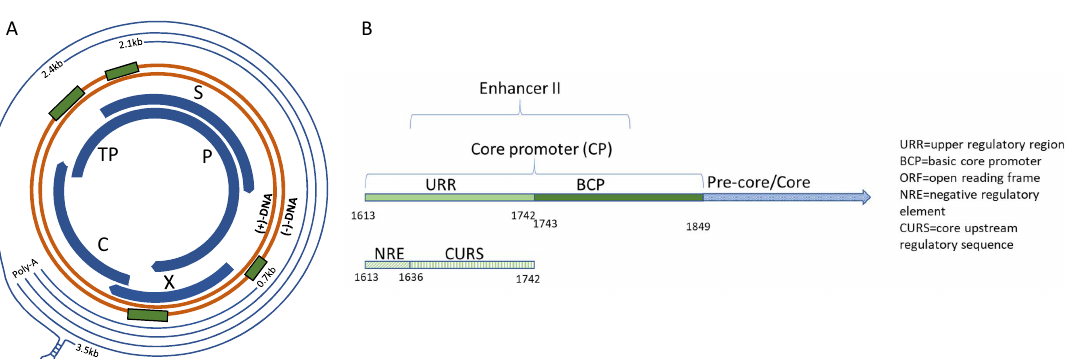
Figure 1. Schematic of the HBV genome. ( A ) From the ( − )-strand DNA, overlapping reading frames code for gene segments C, P, S, and X. Transcripts are depicted by the outer thin lines and ending in the poly-A adenylation sequence. The X and Core promoter regions are highlighted by green rectangles preceding the corresponding gene. ( B ) Core promoter